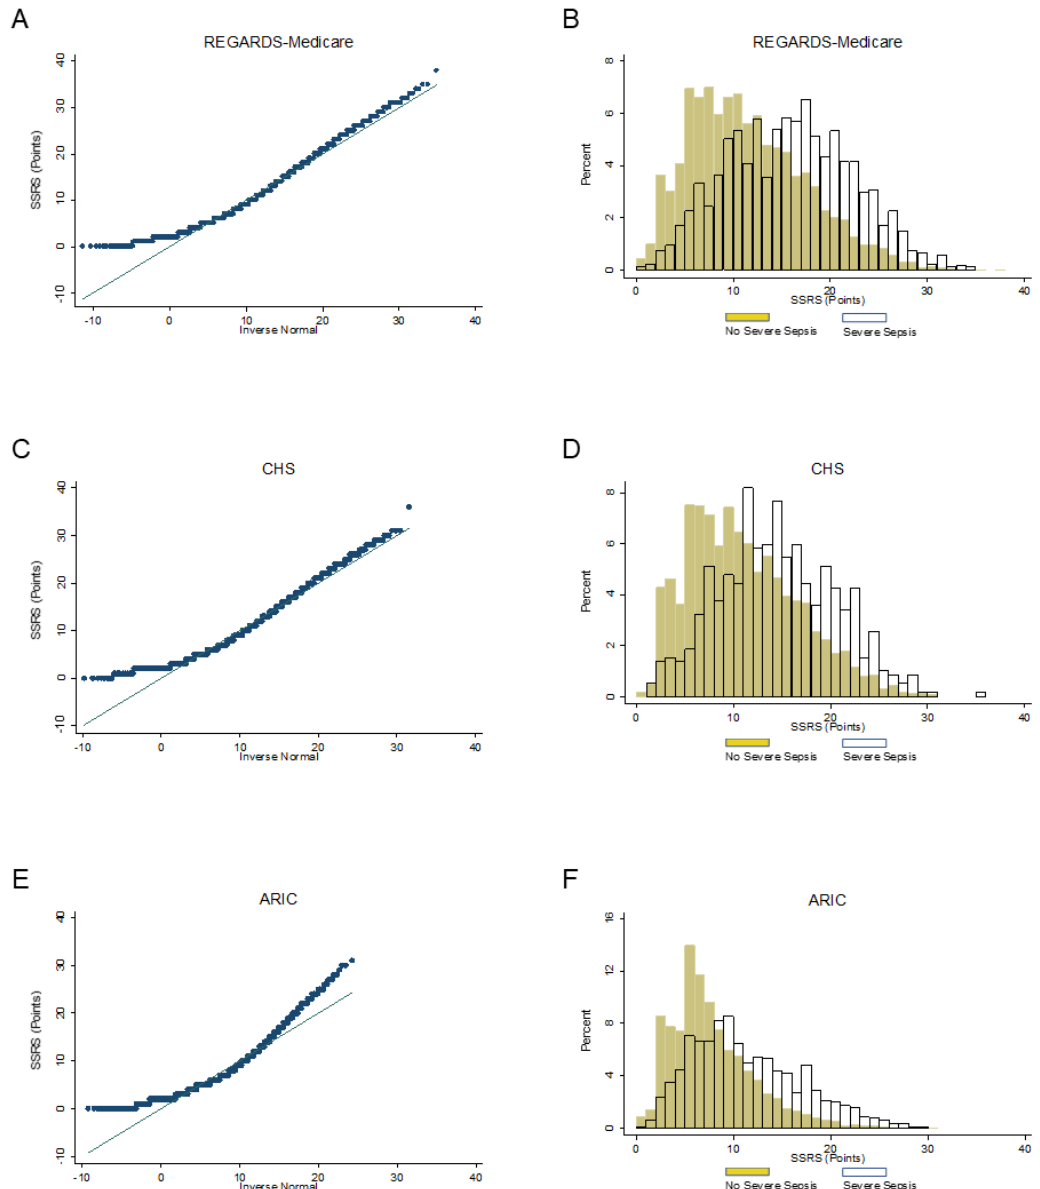
Figure 1. Normality (panels A , C , E ) and distribution (panels B , D , F ) of the REGARDS Severe Sepsis Risk Score in REGARDS-Medicare, CHS and ARIC cohorts. REGARDS = Reasons for Geographic and Racial Differences in Stroke. CHS = Cardiovascular Health Study. ARIC = Atherosclerosis Risk in Communities.